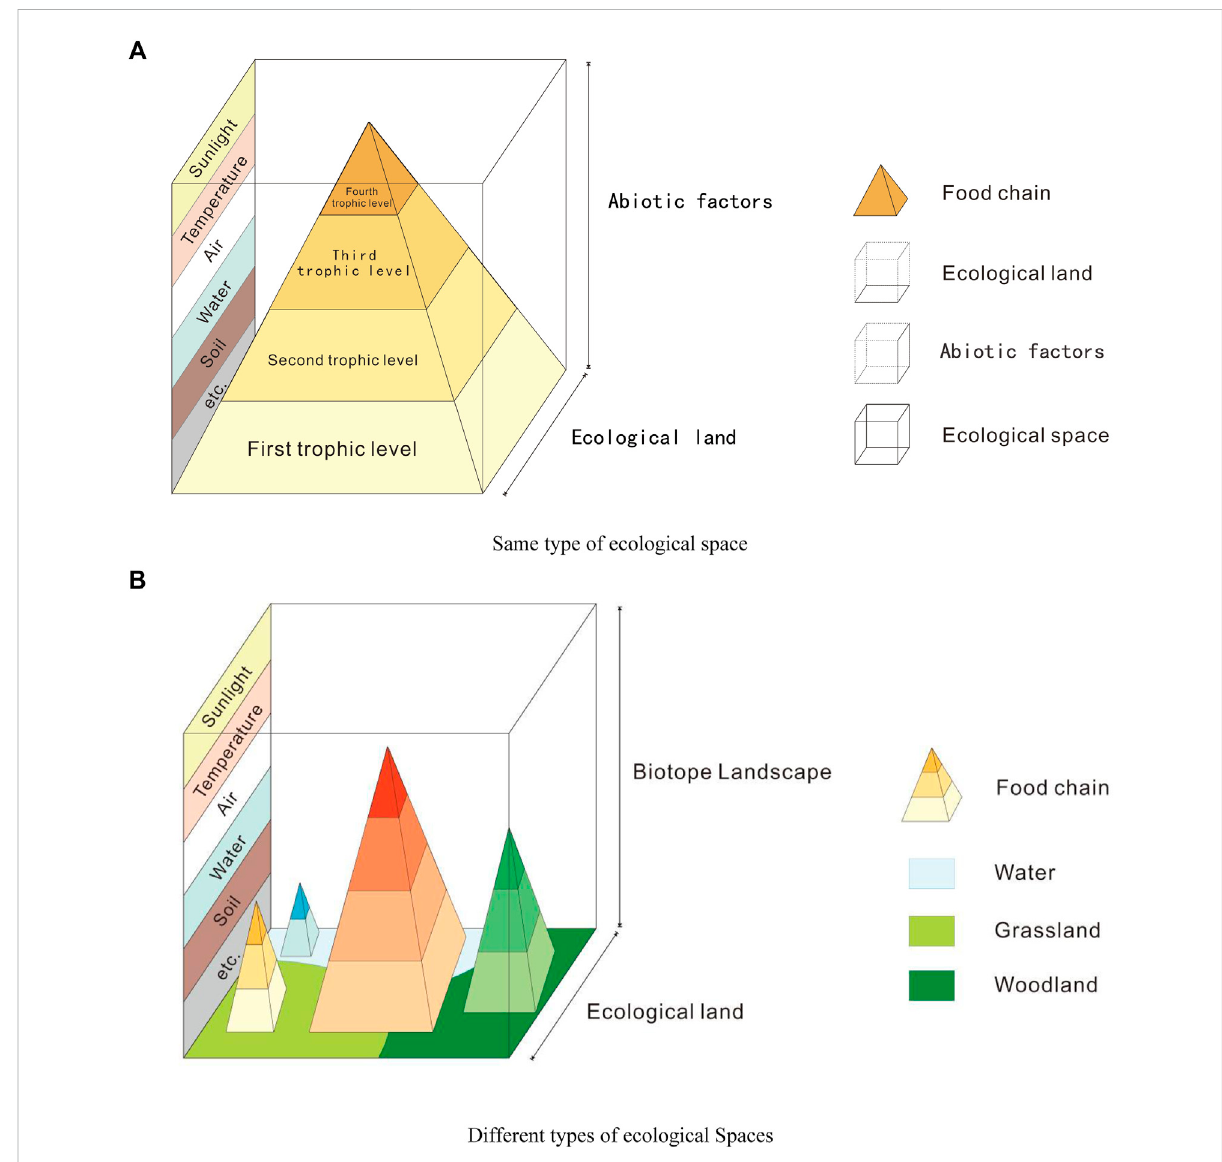
FIGURE 1 Ecological space schematic. (A) Same type of ecological space, (B) Different types of ecological